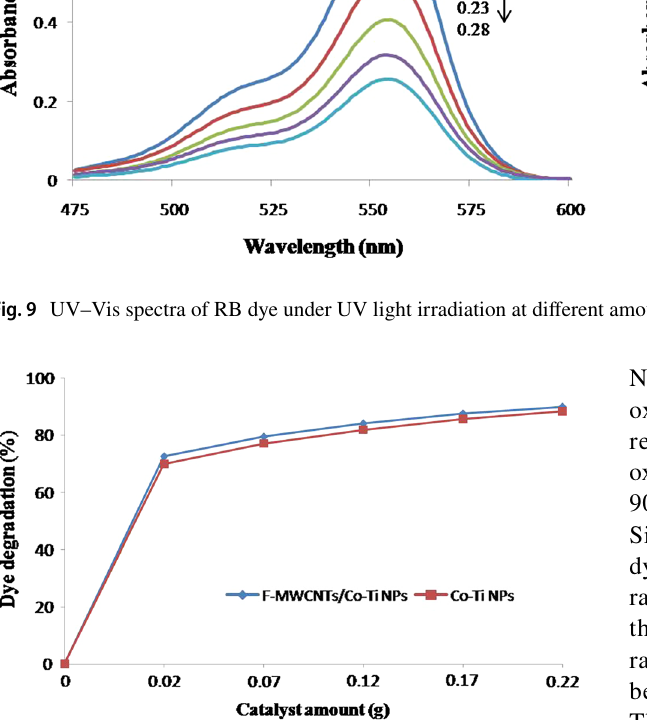
NPs. Figure 10 confirms that the F-MWCNTs/Co–Ti oxides degraded more dye than Co–Ti oxide NPs. The results confirmed that 0.08 g of F-MWCNTs/Ag–Co oxide NPs degrades about 72.64% dye, which increases to 90.01% by increasing to the maximum dosage of 0.28 g. Similarly, 0.02 g of Ag–Co oxide NPs degraded 69.85% dye while increasing catalyst dosage to 0.22 g photodeg- radation of RB dye increases to 88.38%. The results show that increasing catalyst up to certain limit rate of deg- radation increases and then increasing catalyst amount beyond that limit levels off the photodegradation rate. The reason for this phenomenon is that increasing cata- lyst amount increases quantity of photons adsorbed which consequently enhances the photodegradation rates. On the other, further increase in catalyst dosage beyond the limit increases solution opacity leading to decrease in photon penetration, hence decreasing photodecomposition rate (Reza et al. 2017).